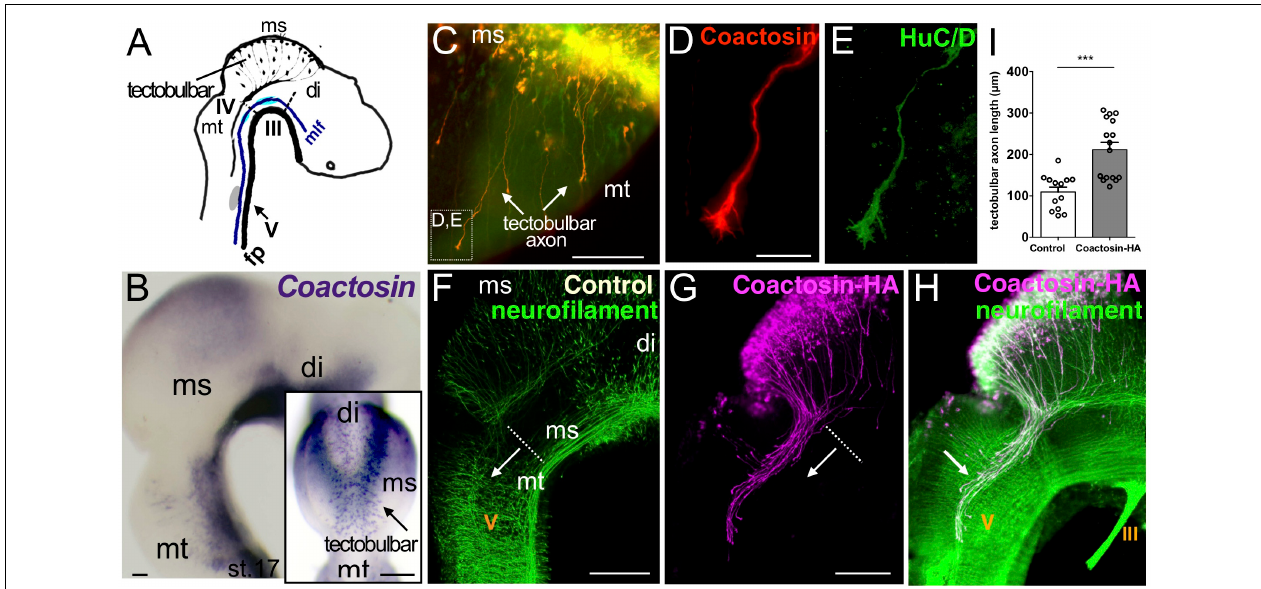
FIGURE 1 | Coactosin localized to growth cones of tectobulbar axons of the midbrain. (A) Schematic representation of axonal tracts in the chick mesencephalon (ms). Tectobulbar neurons project their axons ventrally, turn caudally before reaching the tegmentum, and elongate alongside medial longitudinal fascicule (mlf). (B) Expression of coactosin mRNA in the dorsal midbrain (tectum) in chick embryos at stage 17. Dorsal view (inset) showing the strong spot-like expression around the dorsal midline (arrow, tectobulbar neuron). (C–E) Coactosin ( red ) and HuC/D ( green ) proteins within tectobulbar axons in the mid-hindbrain region. Tectobulber axons project ventrally from stage 16 (arrows). Higher magnification showing coactosin and HuC/D distribution in the growth cones (D,E ; indicated in C) . (F–H) The overexpression of hemagglutinin (HA)-tagged coactosin leads to the premature elongation of tectobulbar axons at the electroporation side (arrow; G,H ) when compared with the control side (arrow; F ). Double staining with the HA-tag ( magenta ) and neurofilament ( green ) antibodies again shows the axonal distribution of HA-tagged coactosin (H) . (I) Tectobulbar tracts showing axonal elongation with coactosin overexpression, compared with the control (13 and 16 embryos, *** p = 0.0001, Mann–Whitney U test). The length of the axons was measured from the mid-hindbrain boundary (dot-line). Abbreviations: mt, metencephalon; di, diencephalon; III, oculomotor nucleus; IV, trochlear nucleus; V, trigeminal ganglion. Scale bar, 200 µ m in panel (B,F,G) ; 50 µ m in panel (C,D) .